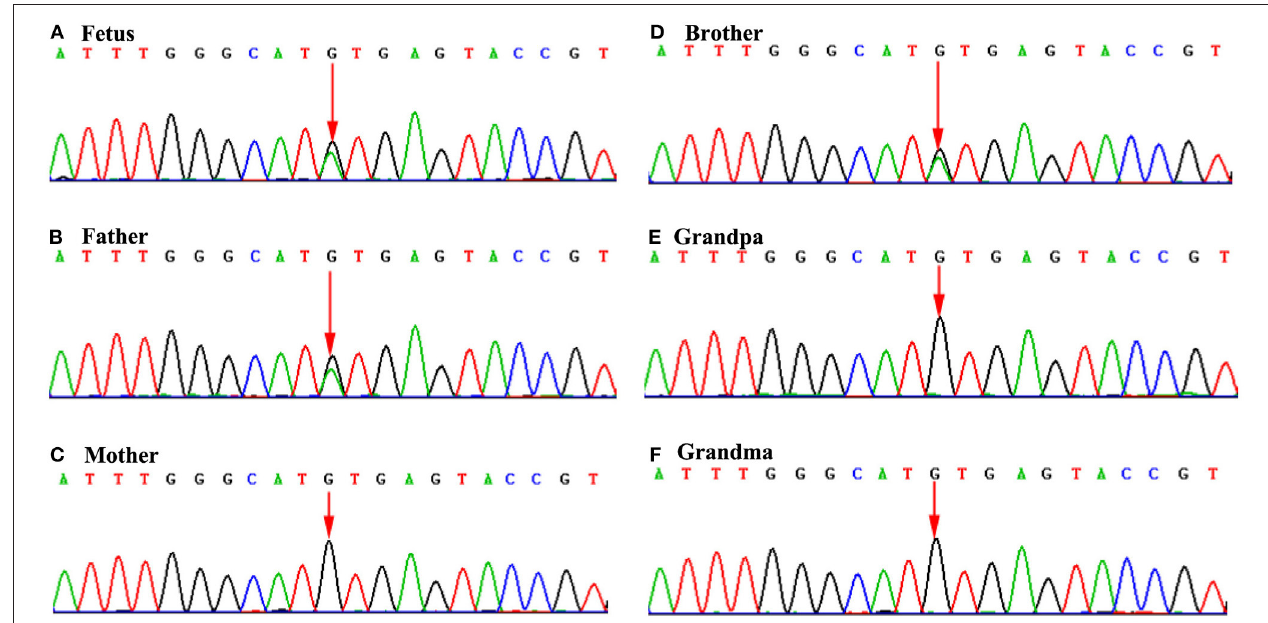
FIGURE 3 | Sequence chromatograms of TBX5 gene in the family members. (A) , (B) , and (D) : Mutation analysis revealed c.510 + 1G > A alteration in splice donor of TBX5 ( A : fetus; B : father; and D : brother). (C) , (E) , and (F) : Mother, grandpa and grandma carries the normal TBX5 gene. *The arrow of (A) , (B) , and (D) indicates the mutation site of TBX5 (c.510 + 1G > A) alteration in splice donor. But the arrow of (C) , (D) , and (F) indicates no